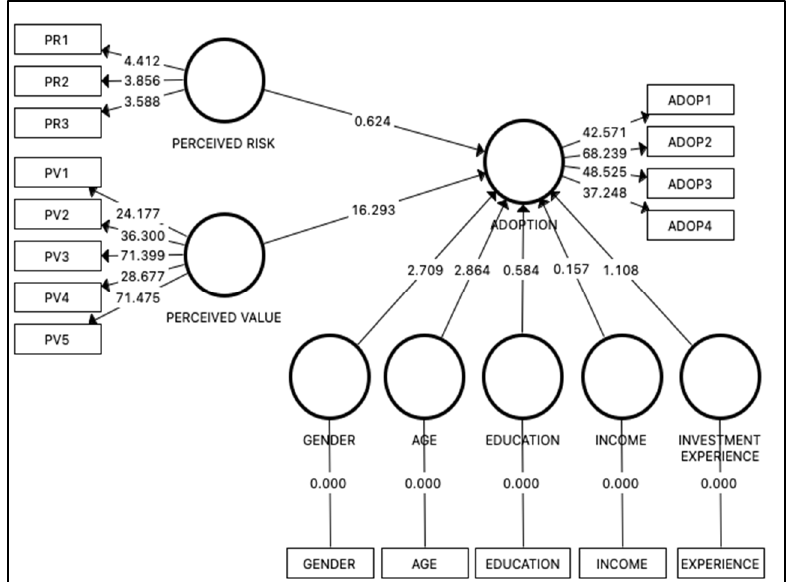
Figure 2. Structural model assessment results.